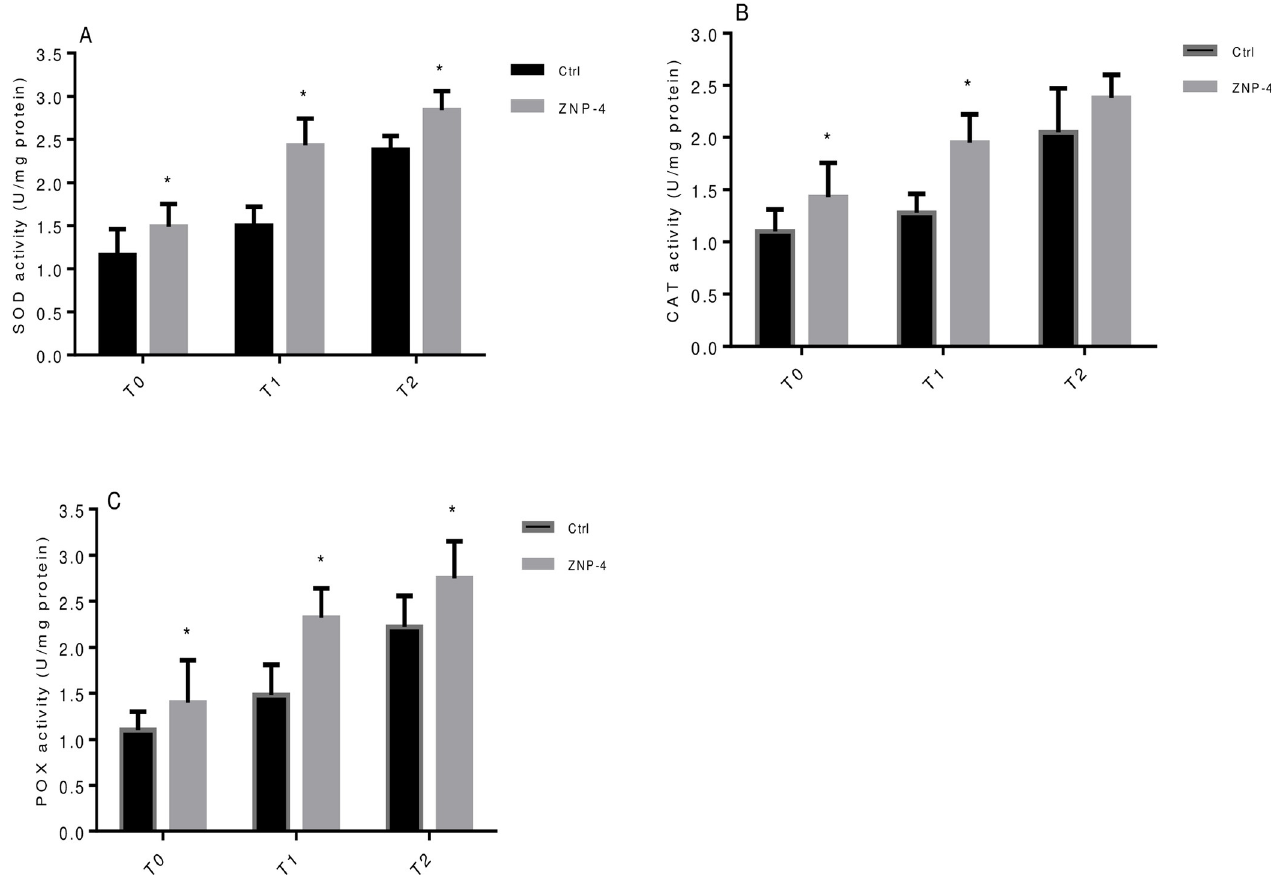
Fig 6. Effect of bacterium inoculation on antioxidative activities under tested salinity stress conditions (A) super-oxide dismutase (B) catalase (C) peroxidase. Each value represent the mean ± SD of triplicate sets (n = 15). The significant difference compared to corresponding control has been denoted by � . Error bar represent the standard deviation of triplicate sets with five measurement in each set (n =